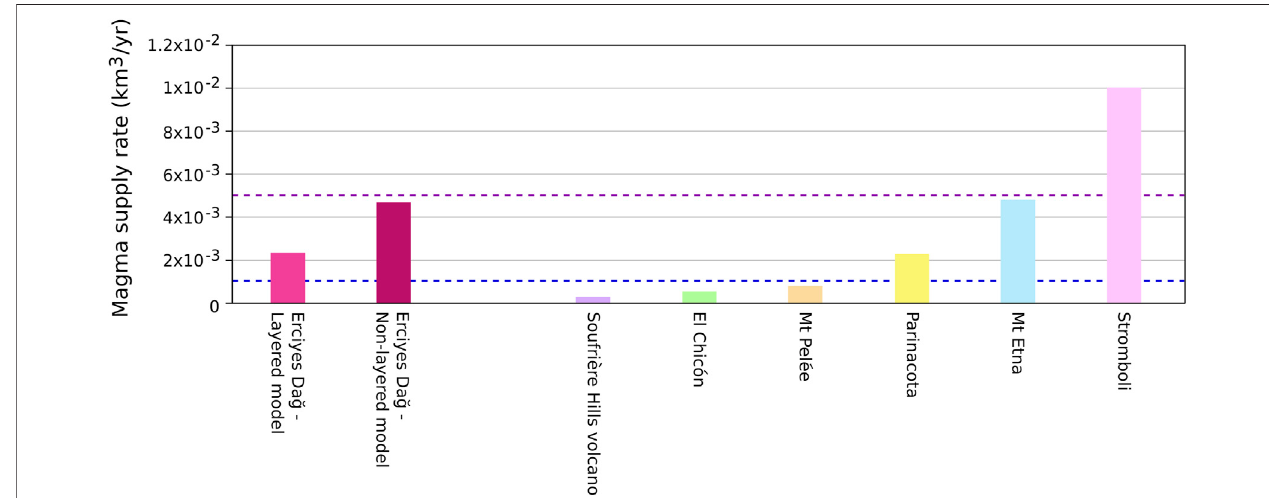
FIGURE 8 | Bar chart of volume fl uxes from this study with reported values from six other stratovolcanoes: Soufrière Hills volcano (Le Friant et al., 2004), El Chicón (Layer et al., 2009), Mt Pelée (Germa et al., 2015), Parinacota (Clavero et al., 2004), Mt. Etna (Branca and Ferrara, 2013), and Stromboli (Allard et al., 1994). The blue dashed line represents the minimum volume fl ux that is required to retain mobile and eruptable magma within the reservoir (Annen et al., 2015). The purple dashed line representstheminimumvolume fl uxrequiredtoproducecaldera-formingsuper-eruptions(Gelmanetal.,2013).Minimumdetectablemagma fl uxesforErciyesDa ğ are representative of the two end-member models (LTM and